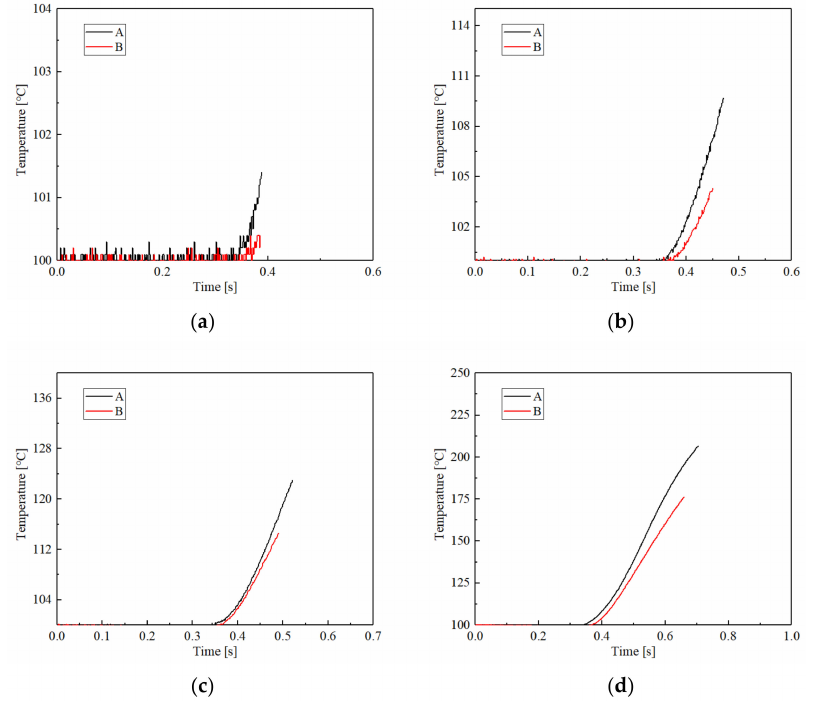
Figure 9. Temperature changes of samples A and B at different rotating speeds. ( a ) 600 rpm; ( b ) 1000 rpm; ( c ) 1500 rpm; ( d ) 2700